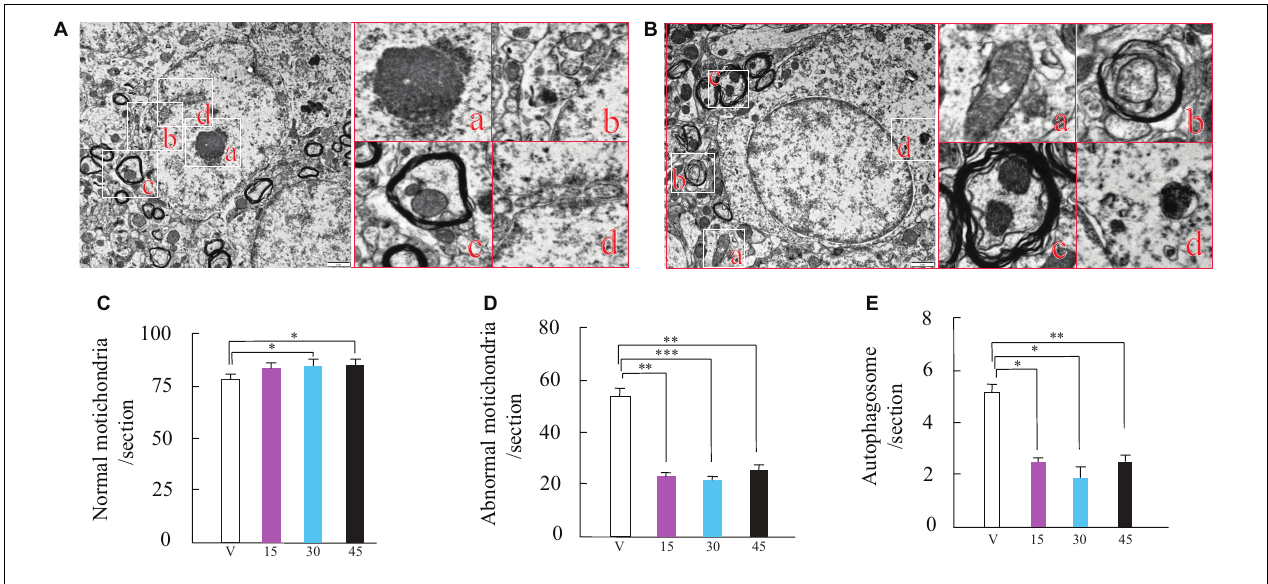
FIGURE 2 | Wen-Shen-Jian-Pi (WSJP) prescription administration for 12 weeks increased normalized mitochondria and decreased abnormal mitochondria and autophagosomes in the AR2 mice. Panels (A,B) show transmission electron microscopy images of spinal cord cells from AR2 mice. (A,a) Nucleus; (A,b) normal mitochondria; (A,c) mitochondrial autophagy; (A,d) abnormal mitochondria; (B,a,b) abnormal mitochondrial autophagy, (B,c) normal mitochondrial autophagy and (B,d) abnormal mitochondria. The scale bar indicates 1 µ m. Frequency histogram of the number of normal mitochondria (C) , abnormal mitochondria (D) and autophagosomes (E) for WSJP-treated AR2 mice [ n = 6 for each of panels (C–E) ] and vehicle (water)-treated AR2 mice ( n = 6); ∗ p < 0.05, ∗∗ p < 0.001, and ∗∗∗ p < 0.0001 vs. the vehicle-treated mice.